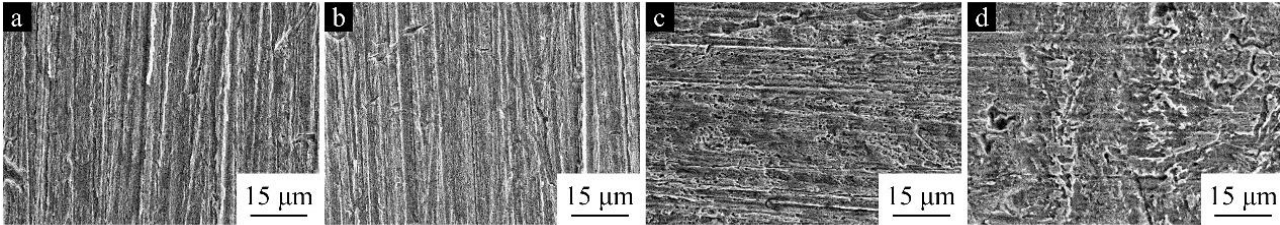
Figure 5. The pH values in different systems on the 14th day (f w/o n: full system without nitrate addition, s w/o n: starvation system without nitrate addition, f with n: full system with nitrate ad- dition, and s with n: starvation system with nitrate addition).